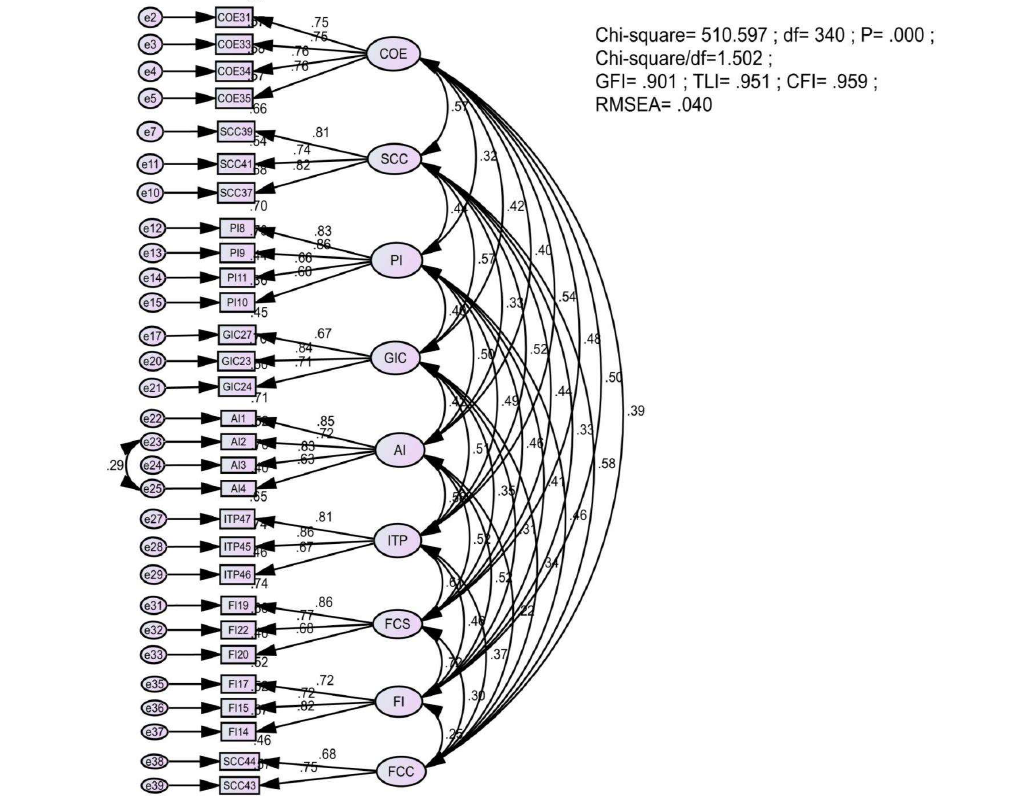
Fig. 3. Standardized measurement